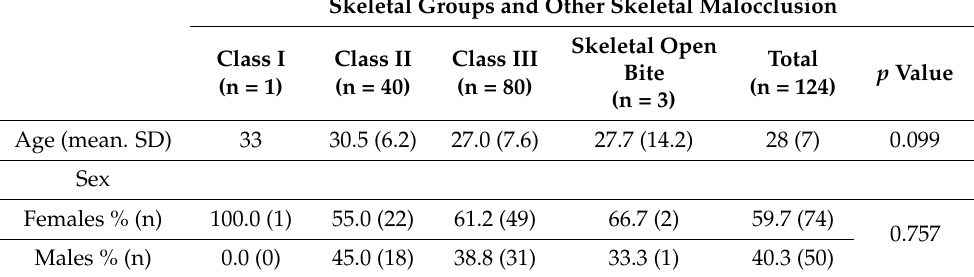
Table 3. Demographic characteristic of the variables according to skeletal groups and other skele- tal malocclusion.